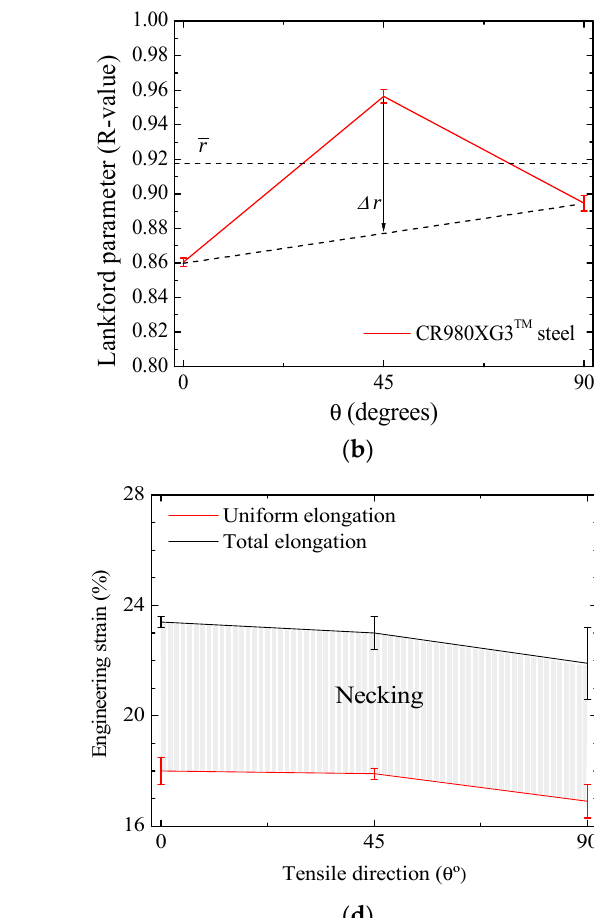
Table 4. Limit strains of the CR980XG3 TM steel sheet determined from the in-plane tests. Uniaxial Tension